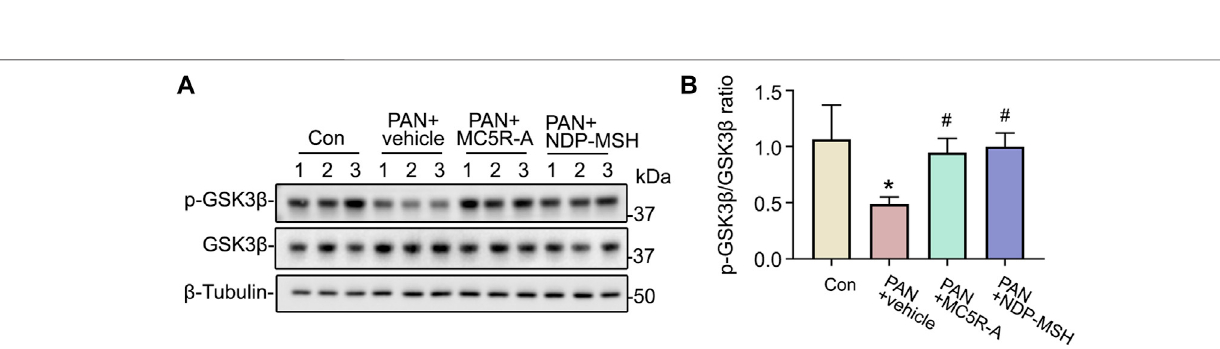
Frontiers in Physiology |